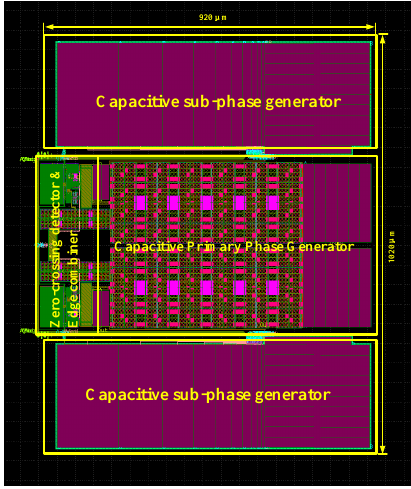
Figure 13. Chip layout of the proposed capacitive FIR-based clock